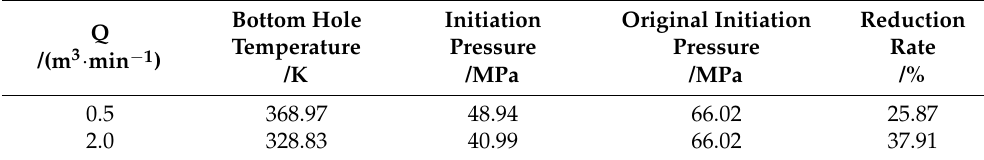
Table 2. Calculation results of initiation pressure at the injection rate of 0.5 m 3 /min and 2.0 m 3